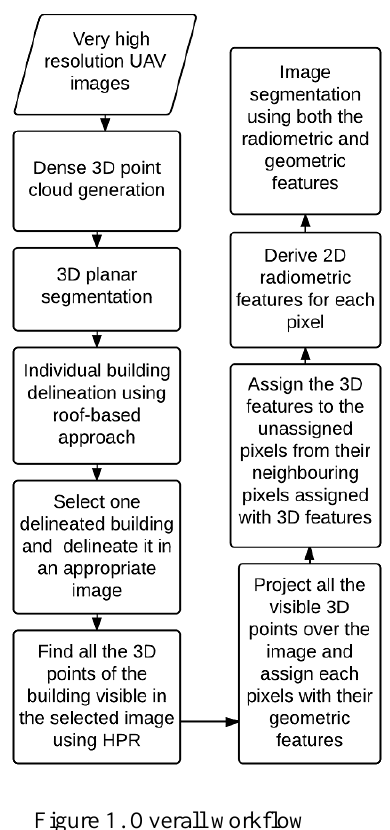
Figure 1. Overall